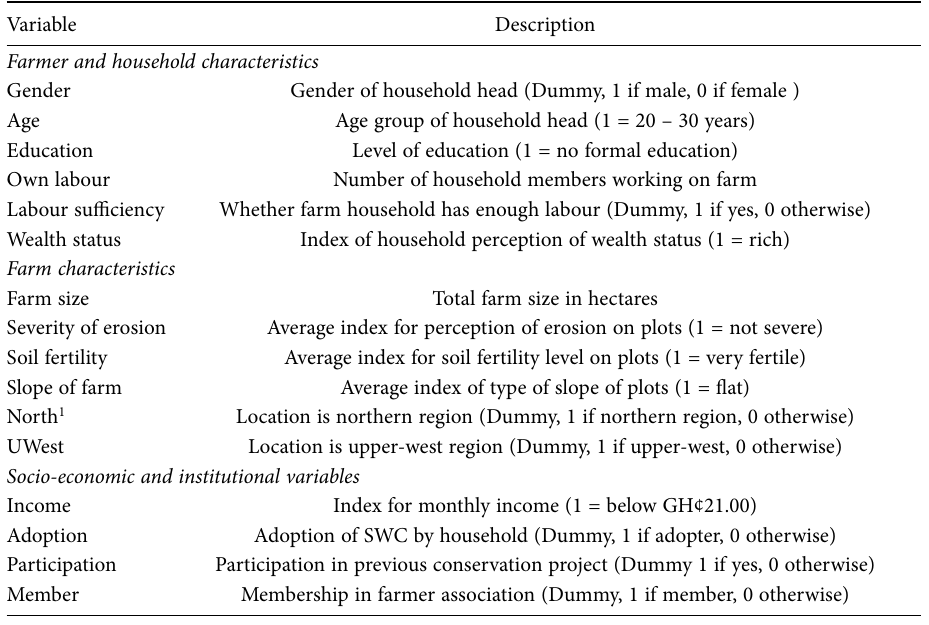
Table 2. Description and statistics of variables used to explain